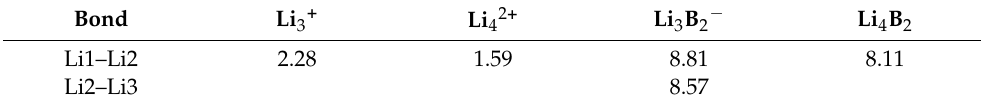
Table 4. Bond current strengths (in nA T − 1 ) for all symmetry-unique bonds. Bond Li 3